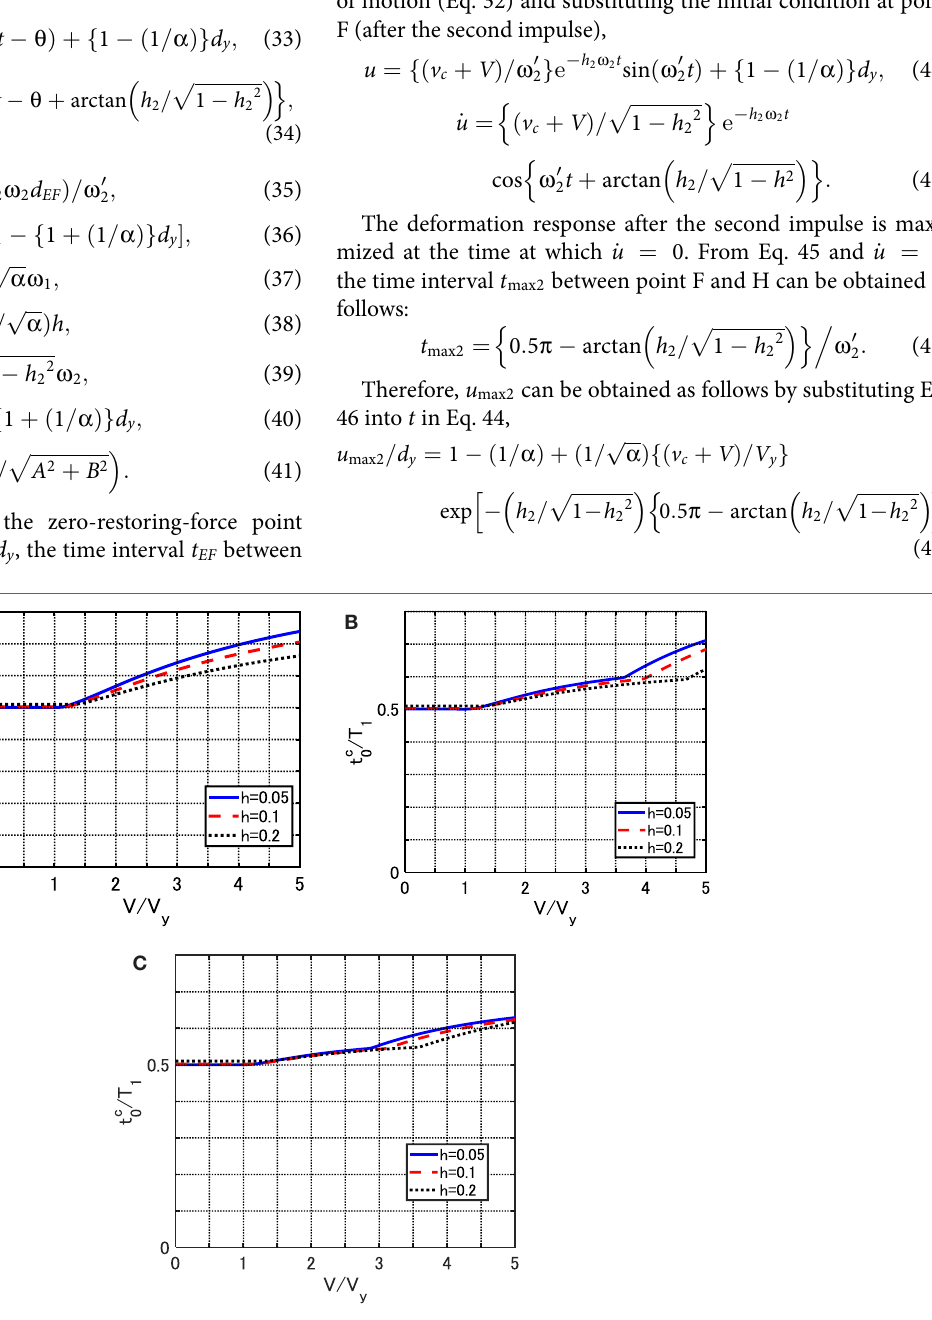
FIGURE 8 | Normalized critical impulse timing t c 0 = T 1 with respect to input level V / V y for various post-yield stiffness ratios α , (A) α = 0.1, (B) α = 0.3, and (C) α = 0.5.